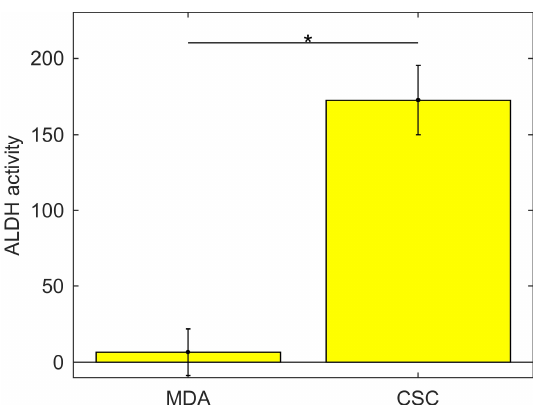
Figure A1. Aldehyde dehydrogenase (ALDH) activity of bulk and CSC enriched MDA-MB-231 cells. Error bars indicate the standard deviation, based on three samples. * Statistically significant at p < 0.05 using a nonparametric Kruskal–Wallis test.